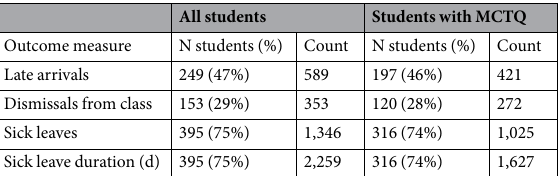
Table 2. Number and percentage (%) of students absent from class. Number and percentage of students are reported separately for the entire student population (523), and for the students who filled in the MCTQ (426). The total counts of late arrivals, dismissals from class, sick leaves, and sick leave duration (days) are also reported.